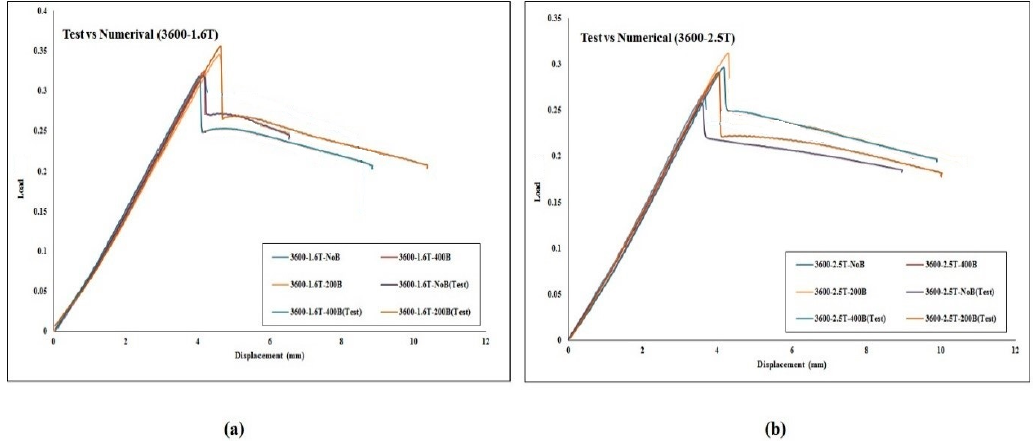
Figure 8. Comparison of the experimental and numerical results of normalised load for ( a ) 3600L-1.6T, ( b )3600L-2.5T.